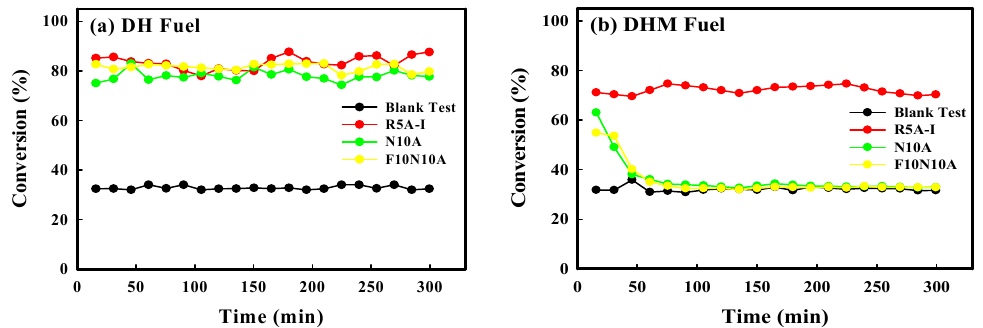
Figure 1. Conversions corresponding to the blank test, R5A-I, N10A, and F10N10A at: ( a ) DH and ( b ) DHM fuel.